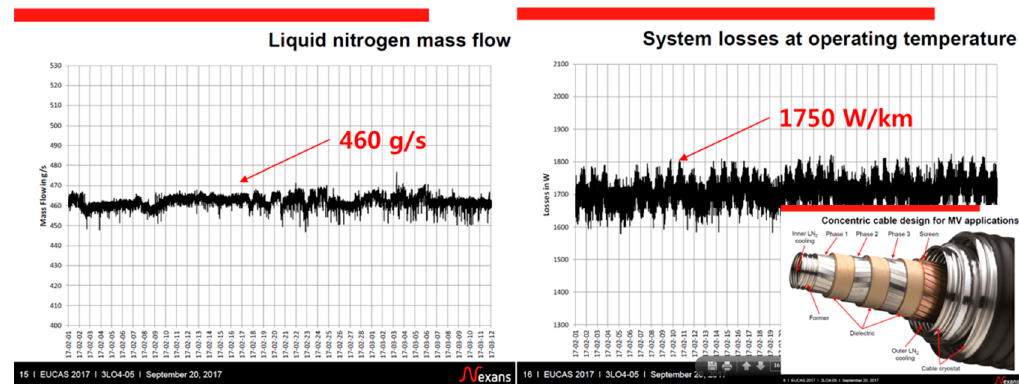
Figure 10. Temperature distribution comparison between Case I and Case III (1 km).